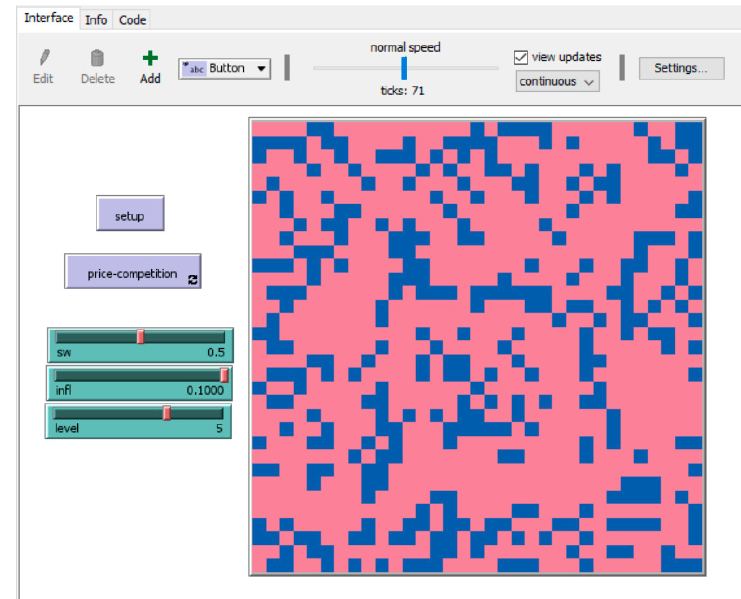
Figure 4. NetLogo window of the ABM program.